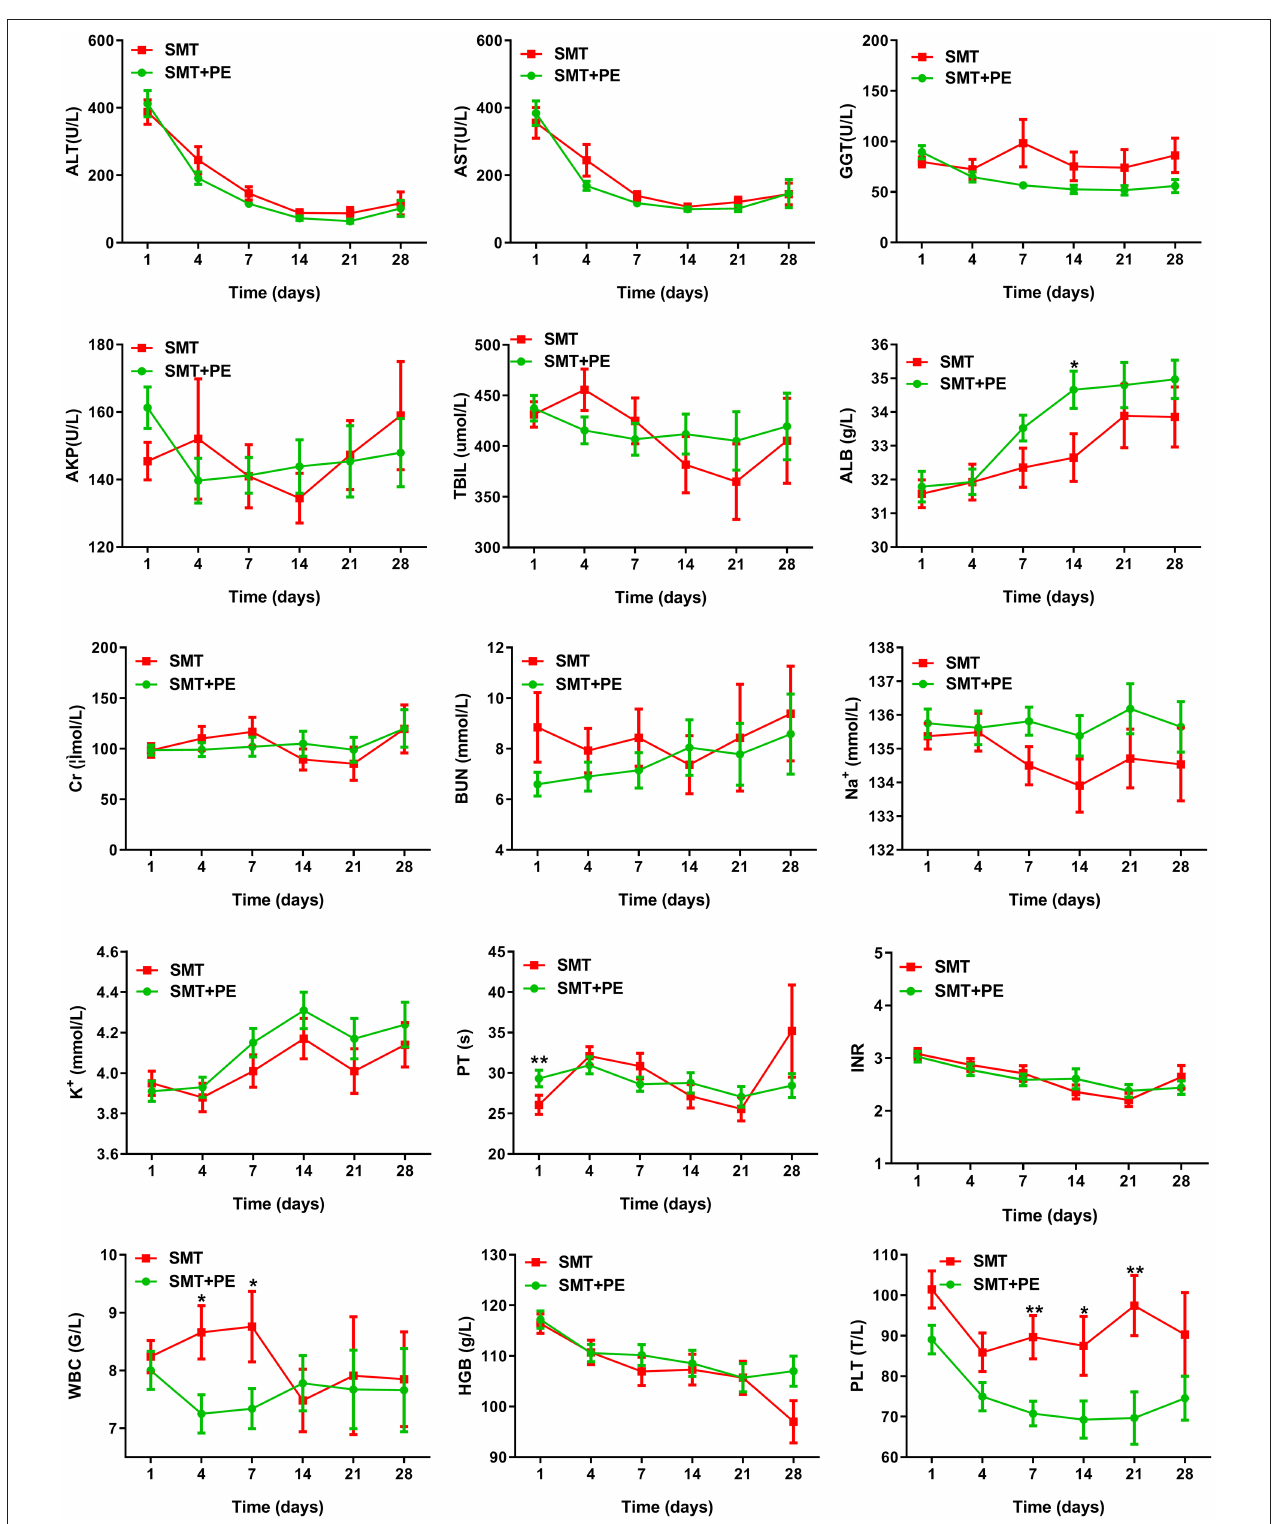
FIGURE 4 | Changes in laboratory parameters in HBV-ACLF patients in the SMT group and SMT + PE group. SMT, standard medical therapy; PE, plasma exchange; ALT, alanine aminotransferase; AST, aspartate aminotransferase; GGT, γ -glutamyltransferase; AKP, alkaline phosphatase; Tbil, total bilirubin; Alb, albumin; Na + , serum sodium; K + , serum potassium; Cr, serum creatinine; BUN, blood urea nitrogen; PT, prothrombin time; INR, international normalized ratio; WBC, white blood cell; HGB, hemoglobin; PLT, platelet; * P value < 0.05; ** P value < 0.01.